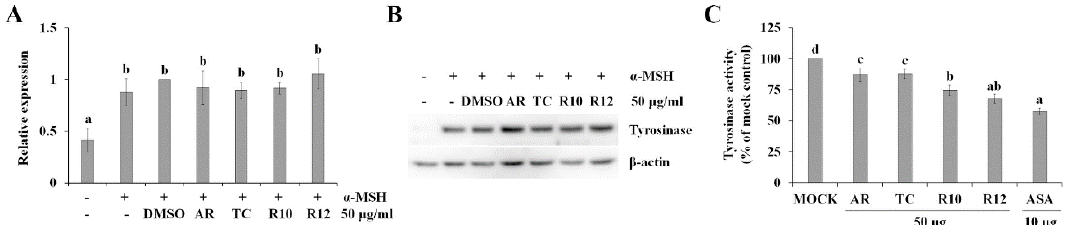
Figure 6. Effect of PAP1-overexpressing ginseng hairy root extracts on the transcription ( A ), translation ( B ), and activity of tyrosinase ( C ). The expression of tyrosinase was normalized to that of β-actin ( A ). ( B ) Total proteins were extracted and assayed by western blotting using tyrosinase-specific antibody. The inhibitory effect of PAP1 -overexpressing ginseng hairy root extracts on tyrosinase activity was analyzed in cell-free conditions, as described in the Materials and Methods. The values represent the means of three replicates ± SE. Values with different superscripted letters are significantly different ( p < 0.05). Transgenic lines: R10 and R12; Transgenic control: TC; Ginseng adventitious root: AR.